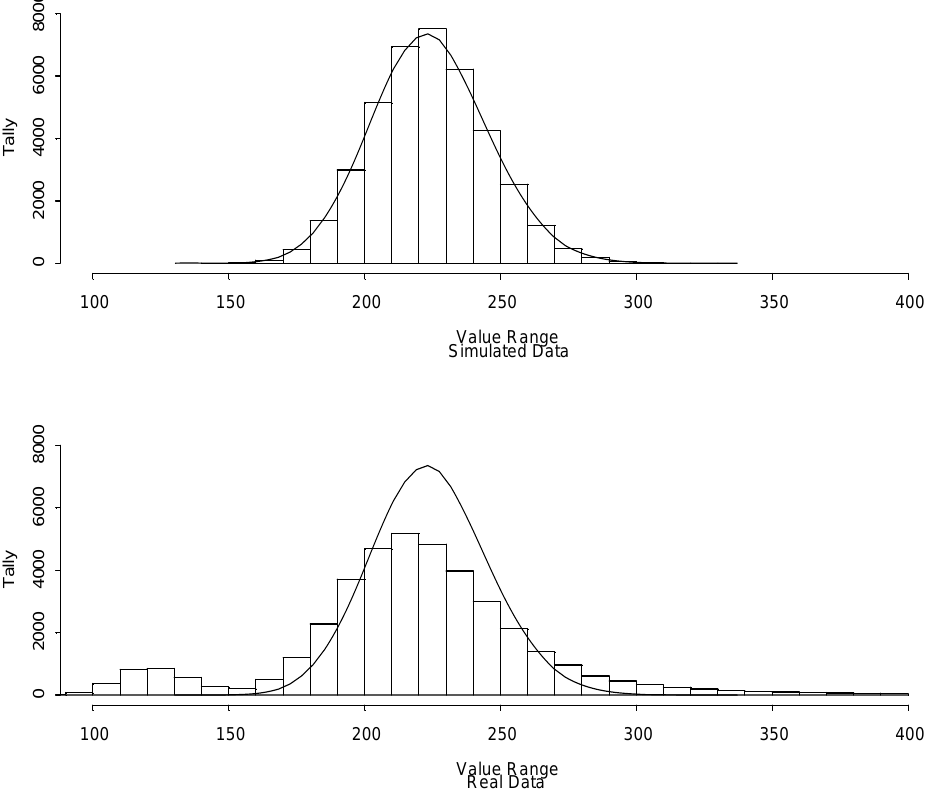
Figure 5. The squared Mahalanobis distances from 40000 (top) simulated r values; (bottom) from randomly-chosen r values from pixels from Scene A. The smooth curve in both plots is based on the χ 2 ( p )